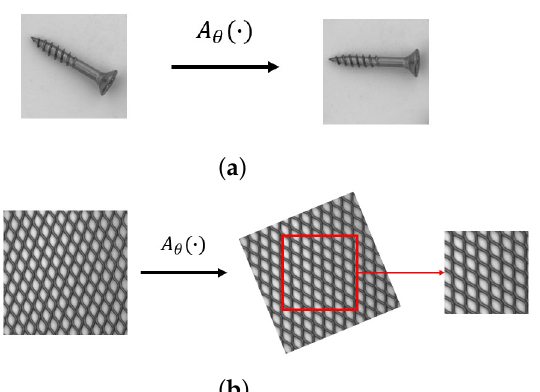
Figure 5. ( a ) Augmentation for non-texture object categories and ( b ) augmentation for texture object categories.